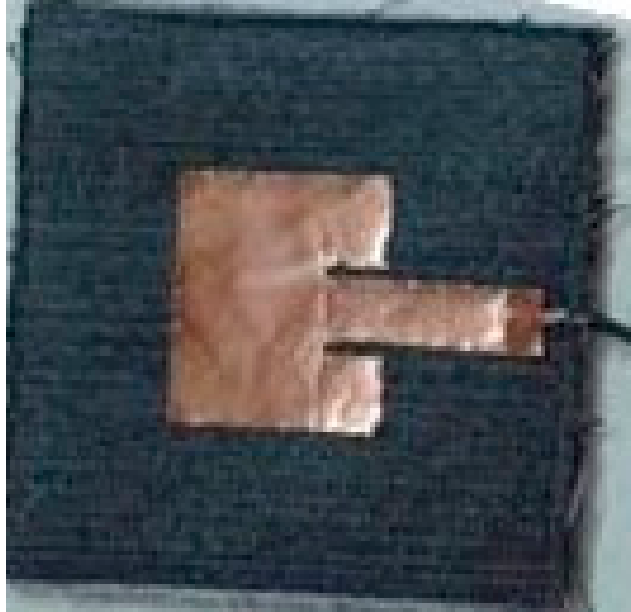
Figure 4. Example of a textile-based implementation of the microstrip patch antenna design using copper tape as radiating patch and denim fabric as the substrate. Reprinted with permission from [67] under the Creative Commons Attribution License.